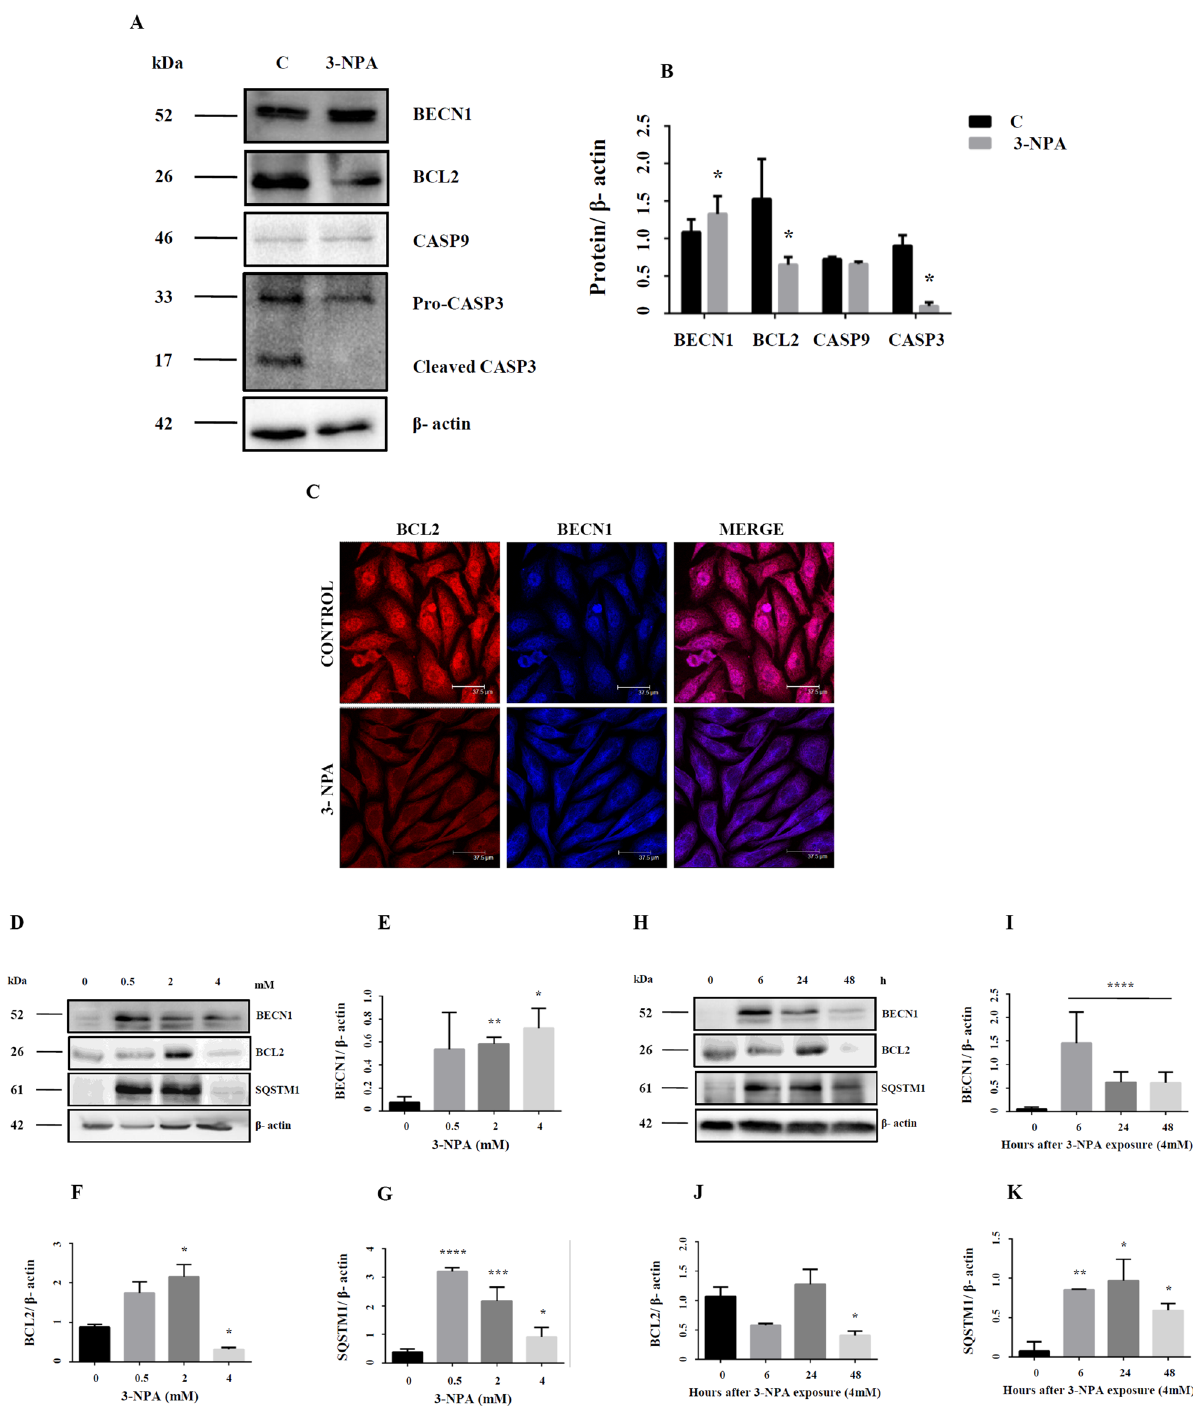
Figure 6. Dynamics between apoptosis and autophagy in 3-NPA treated N27 cells. BECN1, a key molecule in autophagy that balances autophagy and apoptosis was up-regulated ( A , B , corresponding complete blot in supplementary Figure 16i) in 3-NPA treatment. Apoptotic markers BCL2 and CASP3 were down-regulated ( A , B , corresponding complete blots in supplementary Figure 17i and vii) whereas CASP9 was slightly lowered but not statistically significant in 3-NPA treated cells (n = 3 trials per experiment; *p < 0.05). In case of CASP3, along with lowered pro-caspase levels in 3-NPA, the active form was also not generated. ( C ) Representative confocal images of control and 3-NPA treated cells stained with BCL2 and BECN1 vs. control (n = 3 coverslips per group). Dose (0–4 mM) ( D – G , corresponding complete blots in supplementary Figure 16ii (BECN1), 17ii (BCL2) and iv (p62)) and time (0–48 h) ( H – K , corresponding complete blots in supplementary Figures 16iv (BECN1), 17iii (BCL2) and vi (p62)) dependence of autophagic and apoptotic markers are shown in 3-NPA vs. control samples (n = 2 trials per experiment; *p < 0.05, **p < 0.01, ***p < 0.001, ****p < 0.0001). The western data for all the proteins in this figure are from independent blots. All blots were cut to retain only the region depicting the protein of